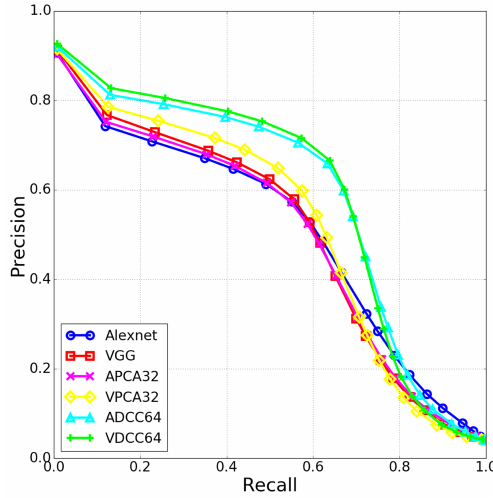
Figure 5. Different methods with the best